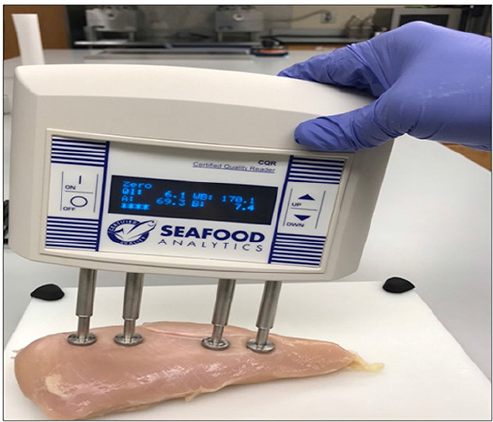
Figure 2. Hand-held BIA setup for the classification of fillets based on different myopathic conditions.